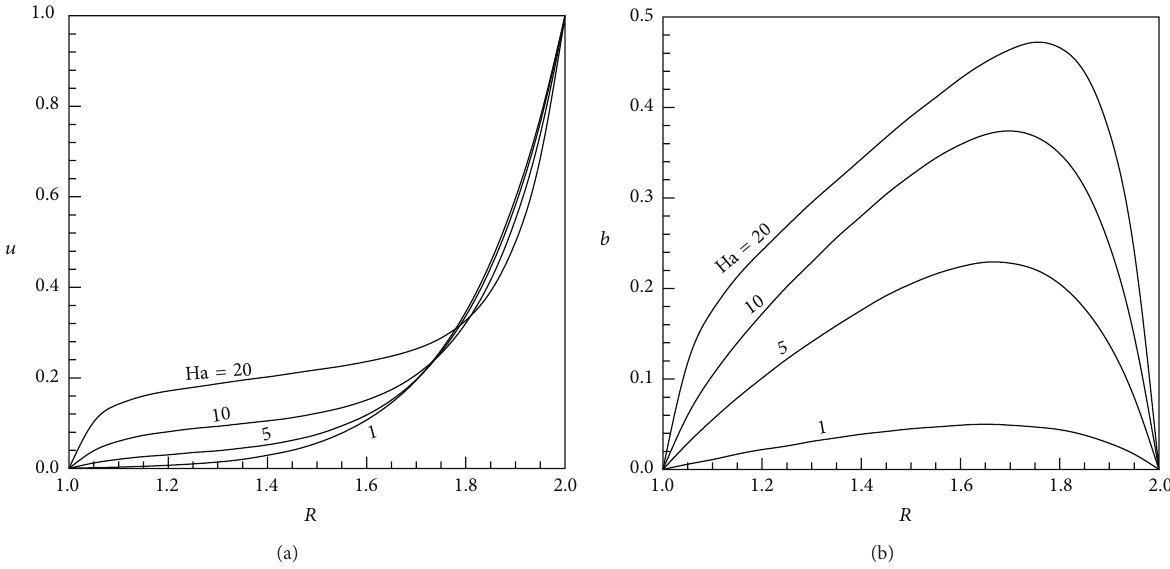
Figure 3: Various profiles for Da = 10 −2 and different values of Ha when both cylinders are insulated: (a) velocity and (b) induced magnetic field.